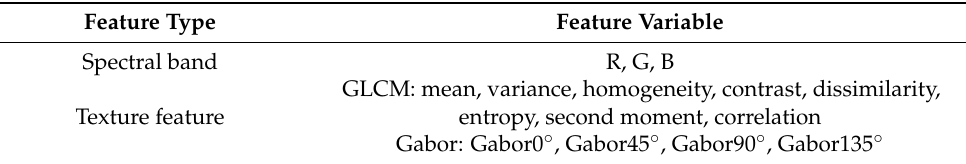
Table 1. Feature variables used to extract the margins of tailings